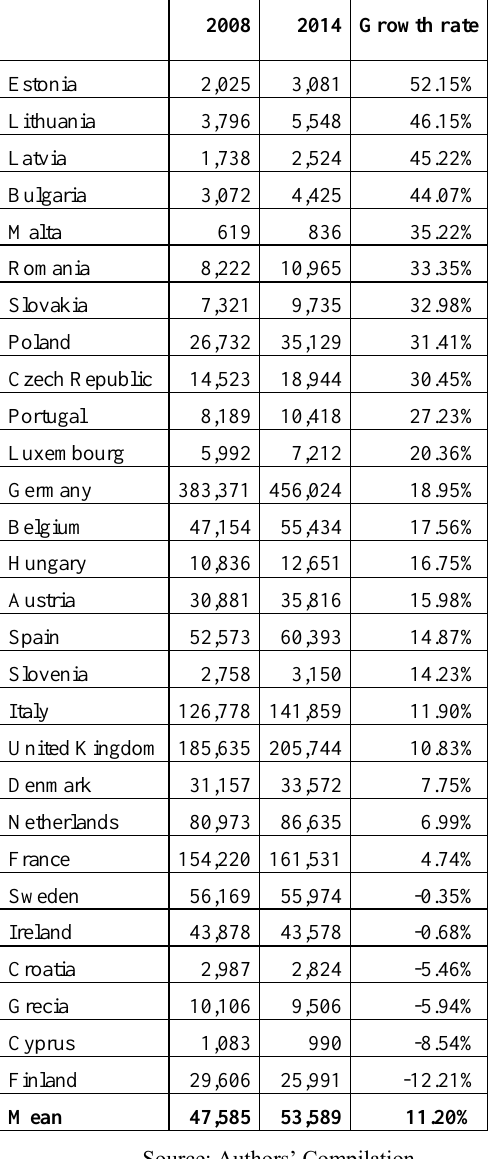
Table 1: EU-28 Value-Added Exports (in $